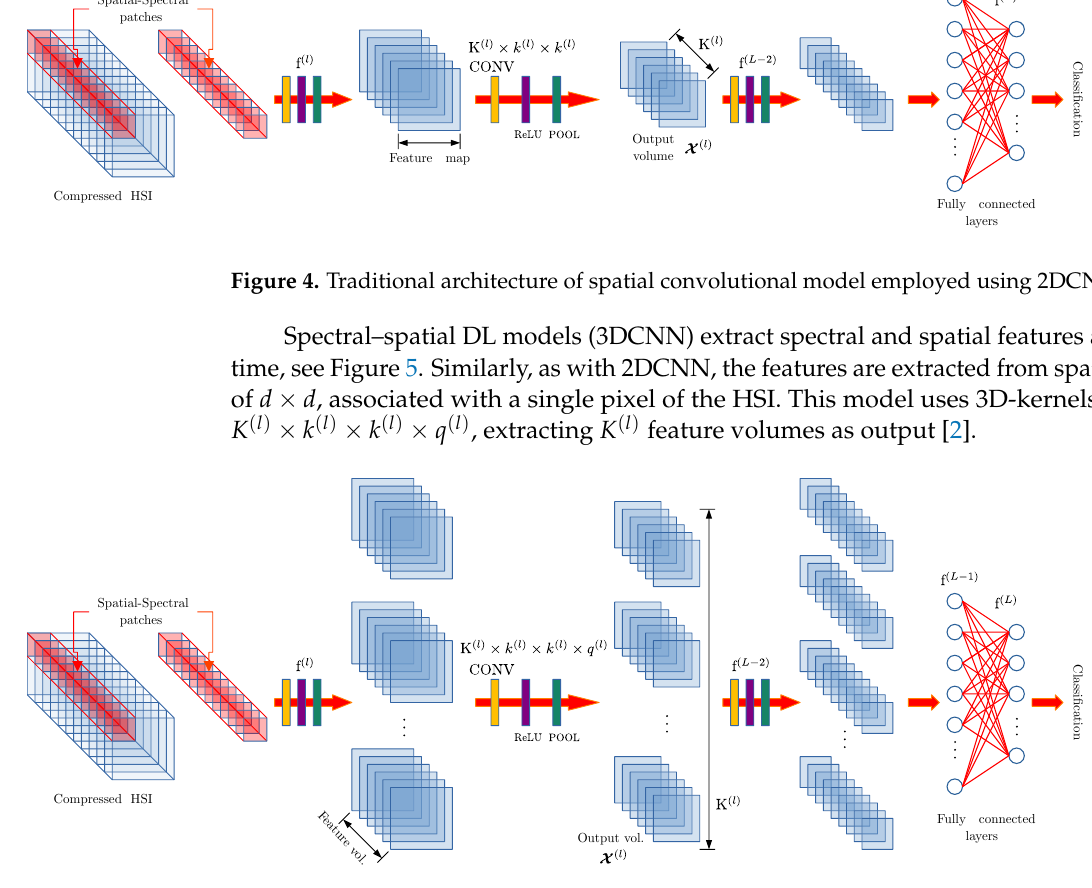
Figure 5. Traditional architecture of spectral–spatial convolutional model employed using 3DCNN [2]. All these spectral feature extraction DL methods basically infer the ground truths based on the spectral signature. Moreover, remote sensing images exhibit an obvious